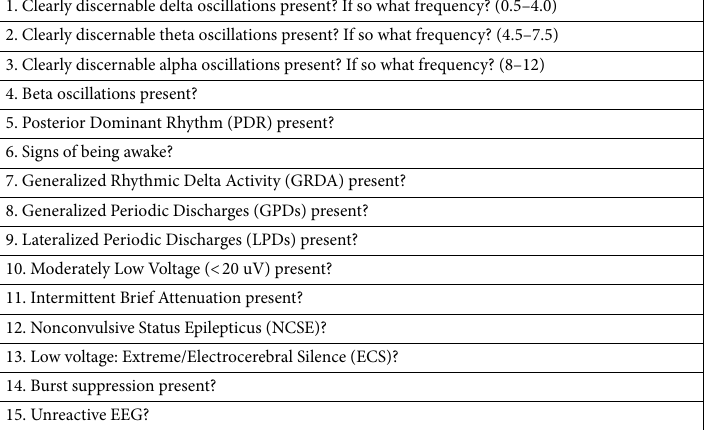
Table 2. Image grading scheme. The grading scheme used in visually grading the EEG images. Features 12–15 represent severe encephalopathy and were automatically assigned worst ICANS severity. Features were translated to a binary mapping for model training by subdividing slowing frequencies into 1 Hz ranges (e.g. Delta frequency 0–1 Hz). Some of these were recombined after training if coefficients were the same (see Table 3).